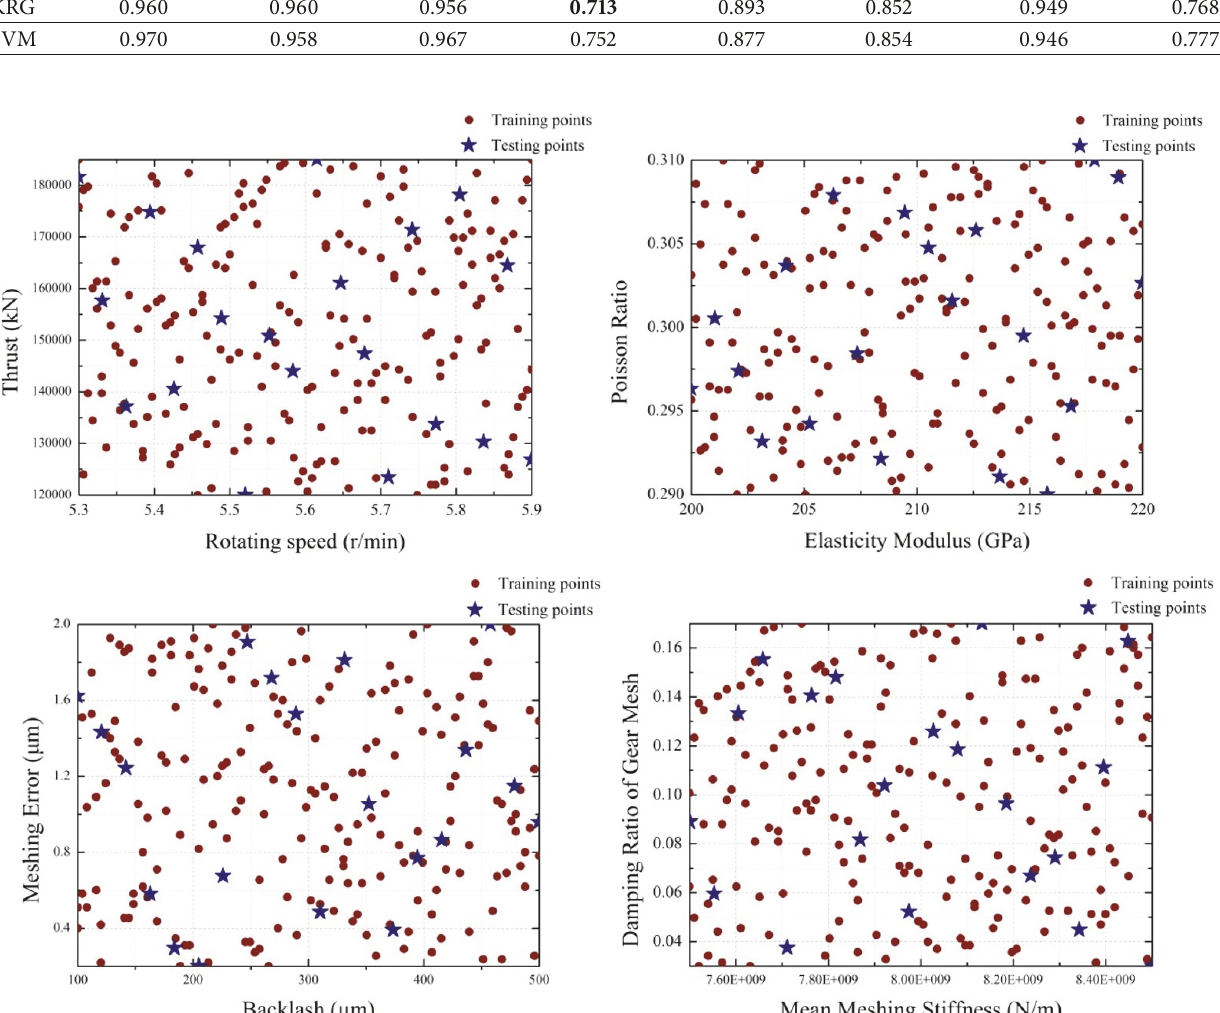
Figure 8: Comparison between training points and testing